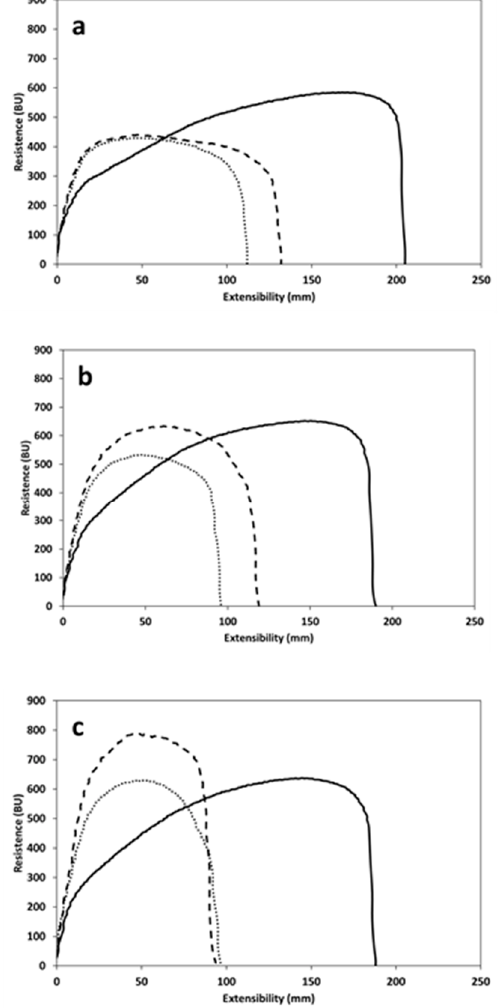
Figure 5. Micro-Extesograph profiles of refined wheat flour alone (solid line) and in presence of bran from un-sprouted wheat (dotted line) or bran from sprouted wheat (dash line), after 45 min ( a ), 90 min ( b ), and 135 min ( c ) of resting time.